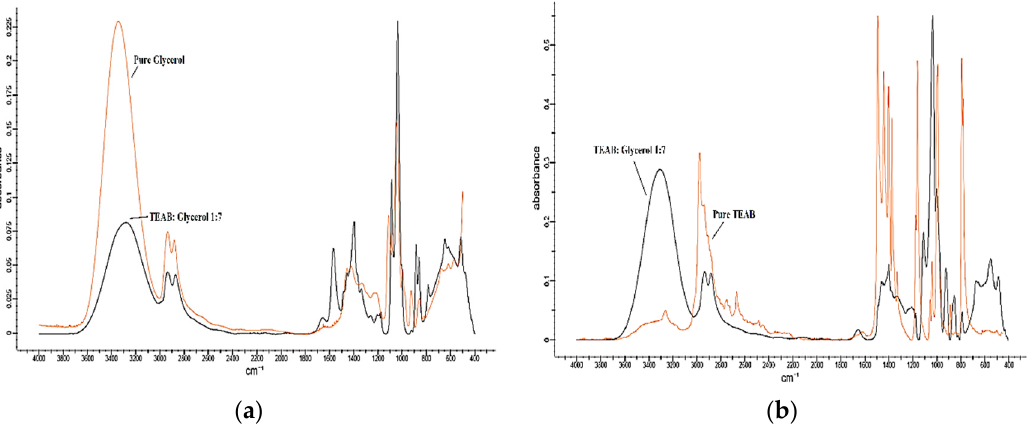
Figure 4. The FTIR comparison of TEAAC:MEG with ( a ) pure MEG and ( b ) pure TEAAC. MEG, Mono-Ethylene Glycol.